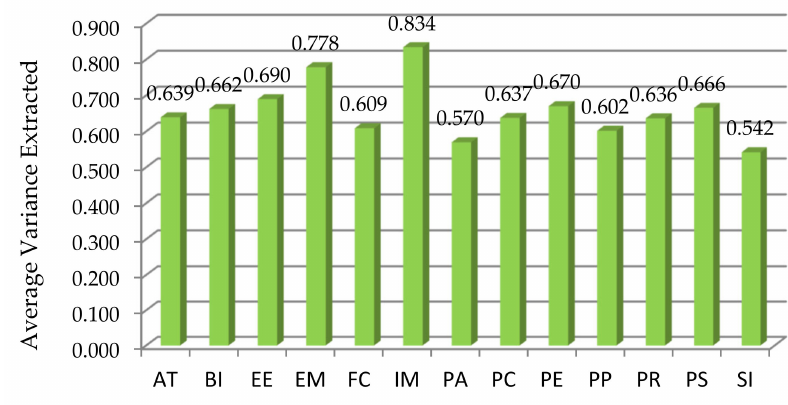
Figure 6. Average Variance Extracted